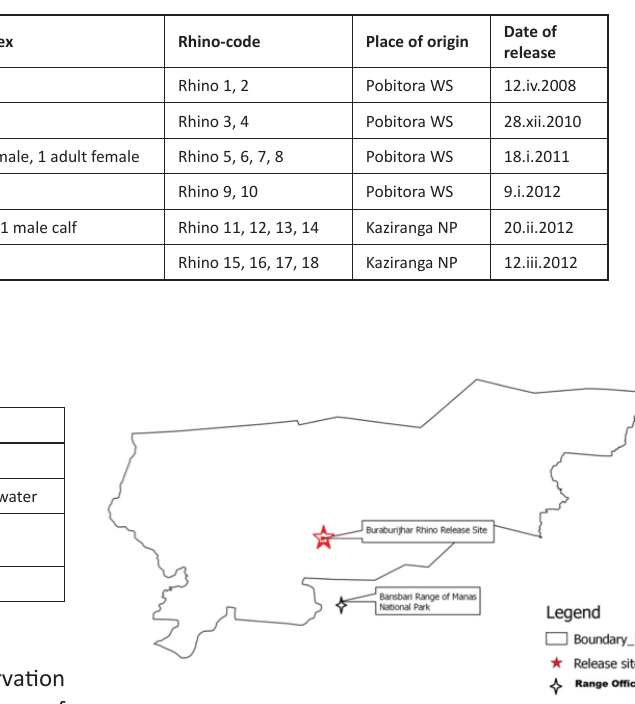
Figure 3. Buraburijhar Rhino release site